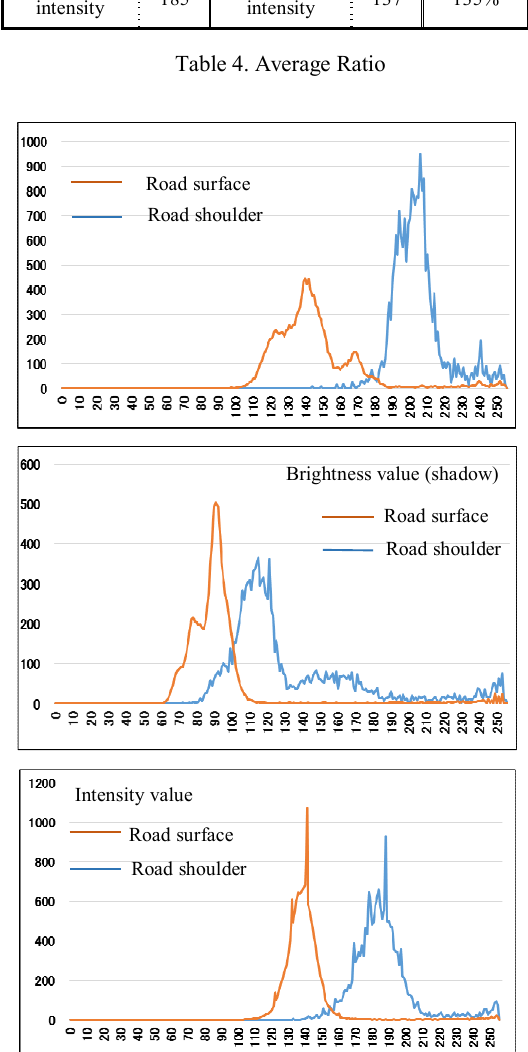
Figure 18. Brightness and intensity value